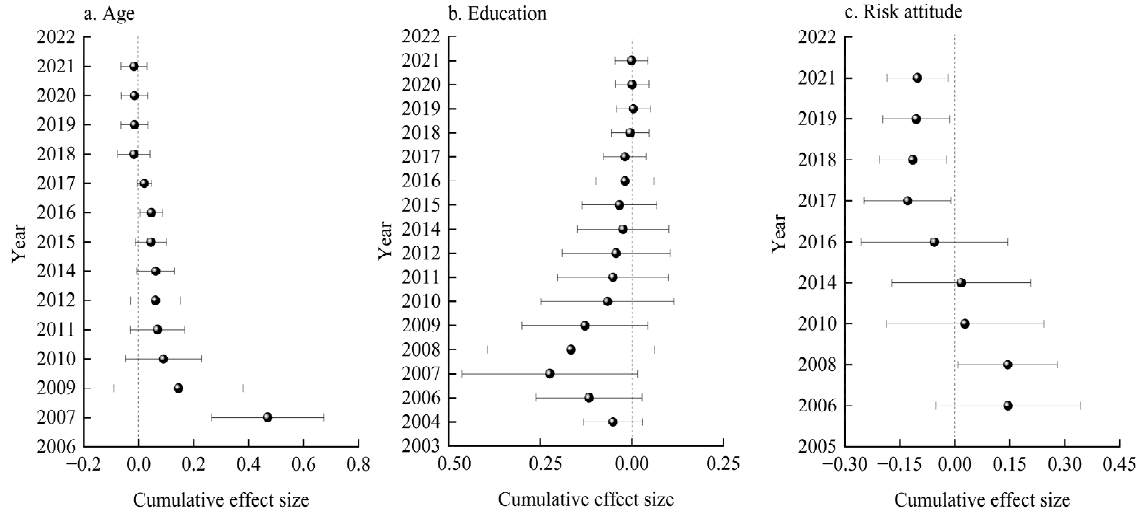
Figure 2. Cumulative meta-analysis trend (individual characteristics).